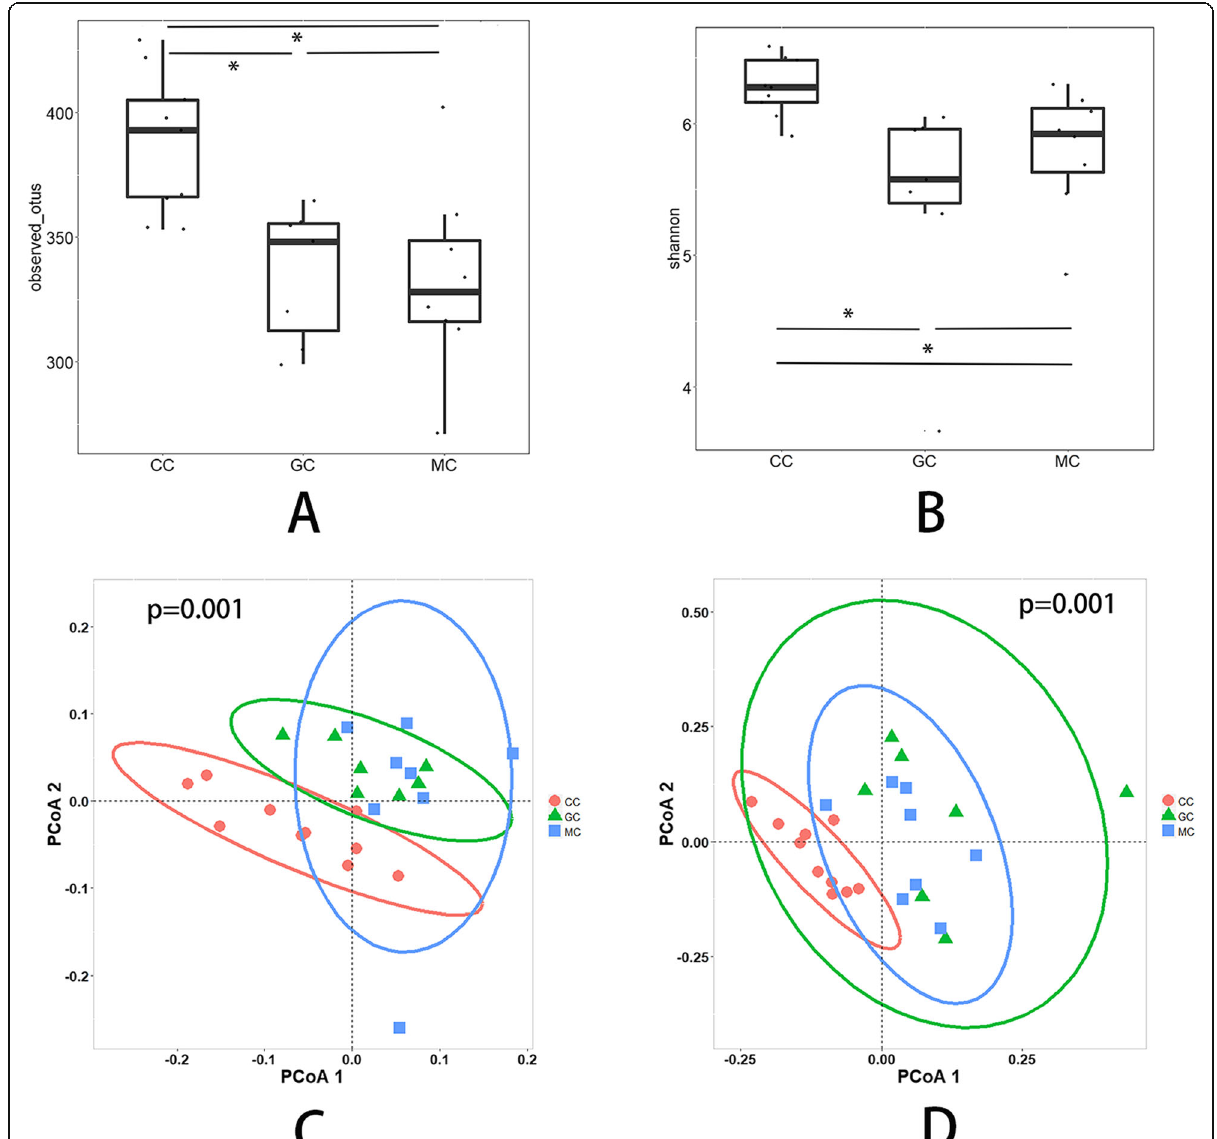
Fig. 2 Analysis of bacterial community diversity. a Alpha diversity index (observed_species index) of intestinal contents within groups; b Alpha diversity index (Shannon index) of intestinal contents within groups; c Beta diversity index (Unifrac distance unweighted PCoA analysis) of *CC: the luminal content of the control group. MC: the luminal content of the model group. GC: the luminal content of the Garidisan group